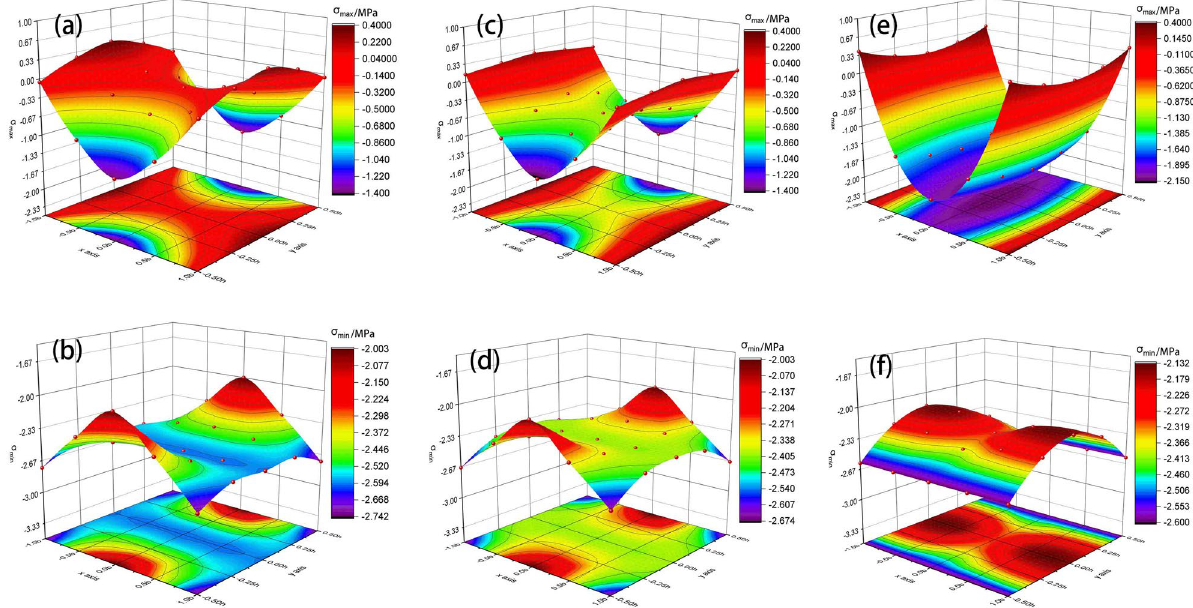
Figure 7. Principal stress distribution of the interlayer when ( a , b ): h/H = 1/2, ( c , d ): h/H = 1/3, and ( e , f ): h/H = 1/8.